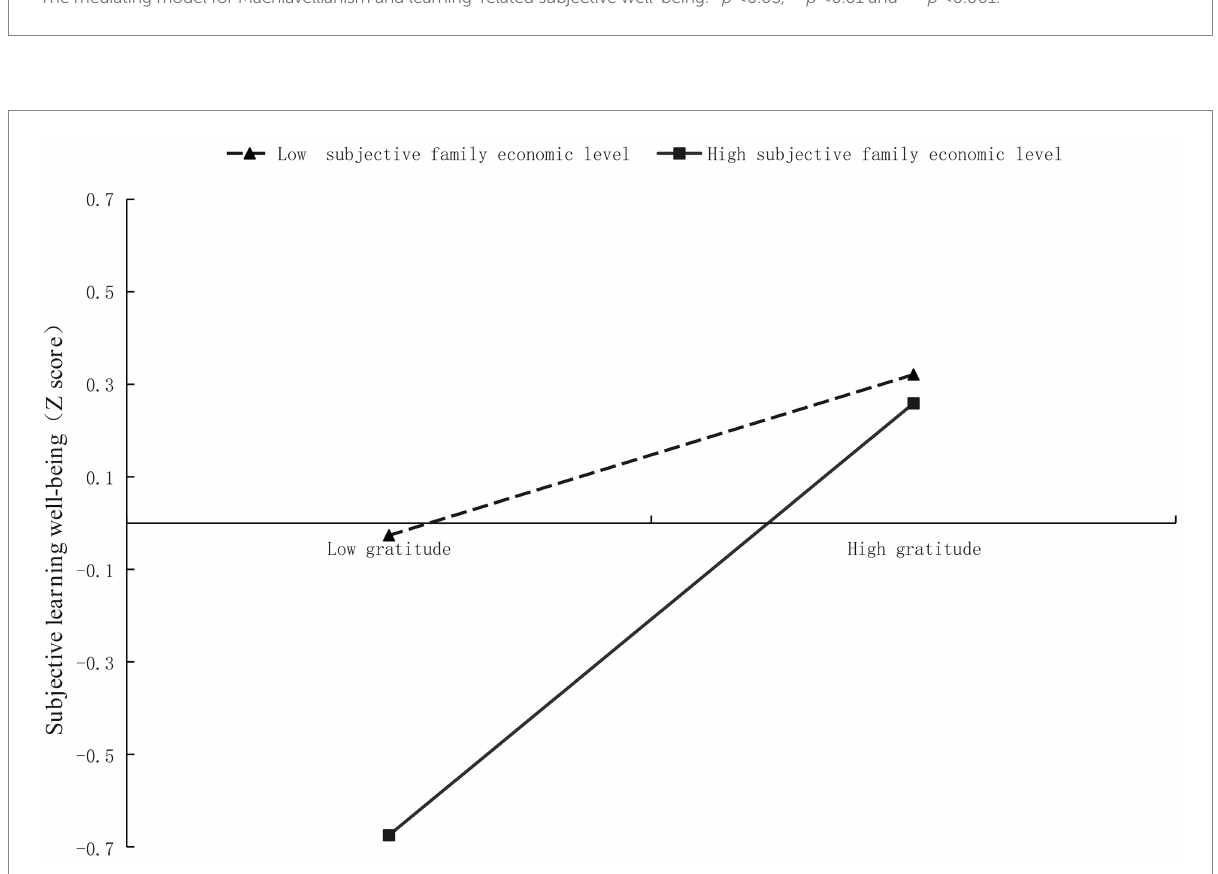
FIGURE 2 The interaction effect of subjective family economic level and gratitude on learning-related subjective